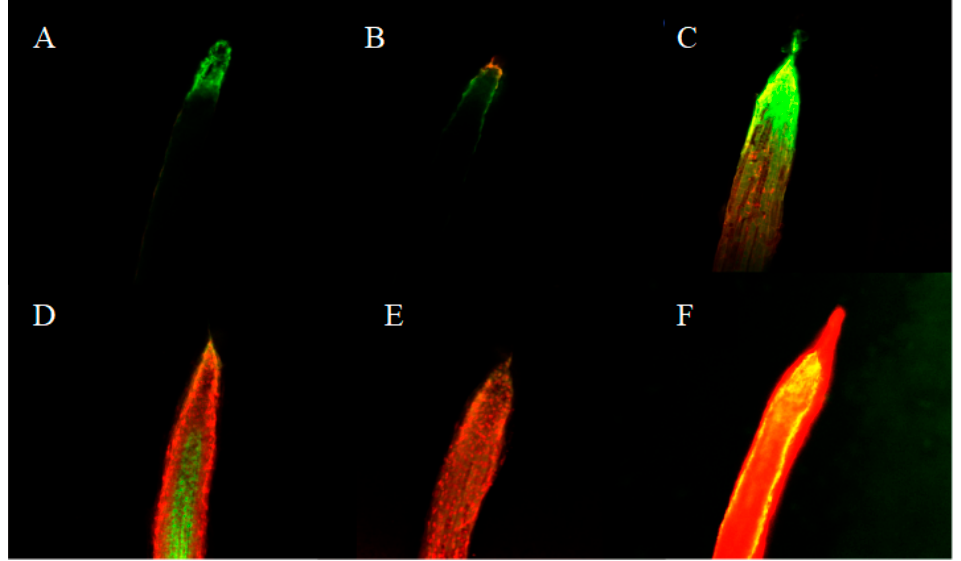
Figure 6. Representative pictures of cell viability in lettuce radicle tips after treatment with different concentrations of isoliquiritigenin. ( A : control, B : 0.2 mM, C : 0.4 mM, D : 0.6 mM, E : 0.8 mM, F : 1.0 mM).